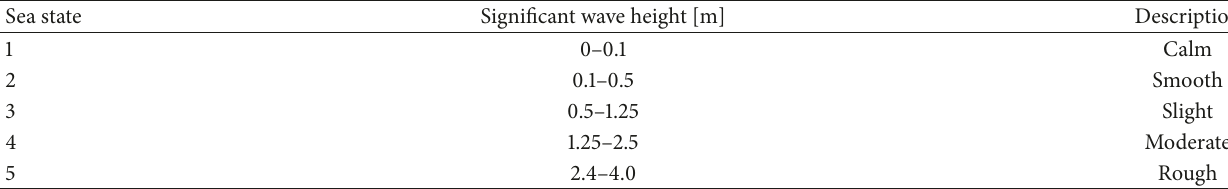
Table 1: Characteristics data for Sea States 1–5.